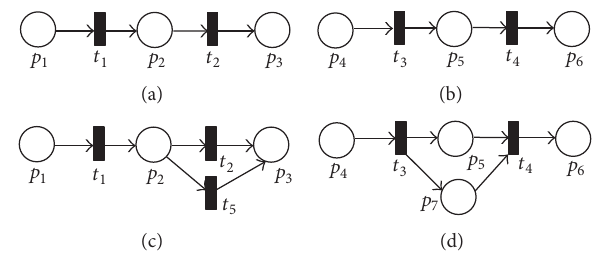
Figure 1: Illustration of linearity